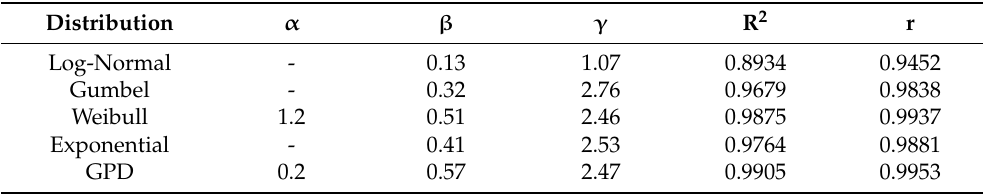
Table 4. Parameter values ( α : shape parameter; β : scale parameter; γ : location parameter) of the best-fitting candidate distribution functions, sum of squares of the error R 2 , and correlation coefficient